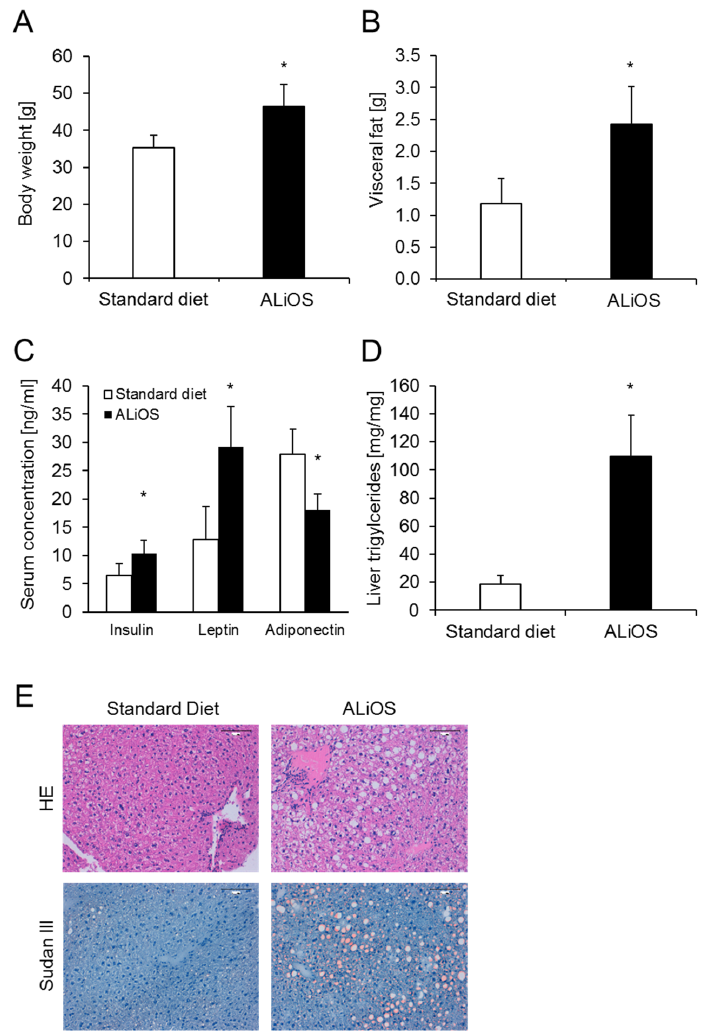
Figure 1. American lifestyle-induced obesity syndrome (ALiOS) diet in mice induces obesity, metabolic syndrome and fatty liver. Wildtype mice were fed standard diet or ALiOS diet for 24 weeks. ( A ) Body weight ( n = 14, each), ( B ) visceral fat weight ( n = 8, each), ( C ) serum concentrations of insulin,